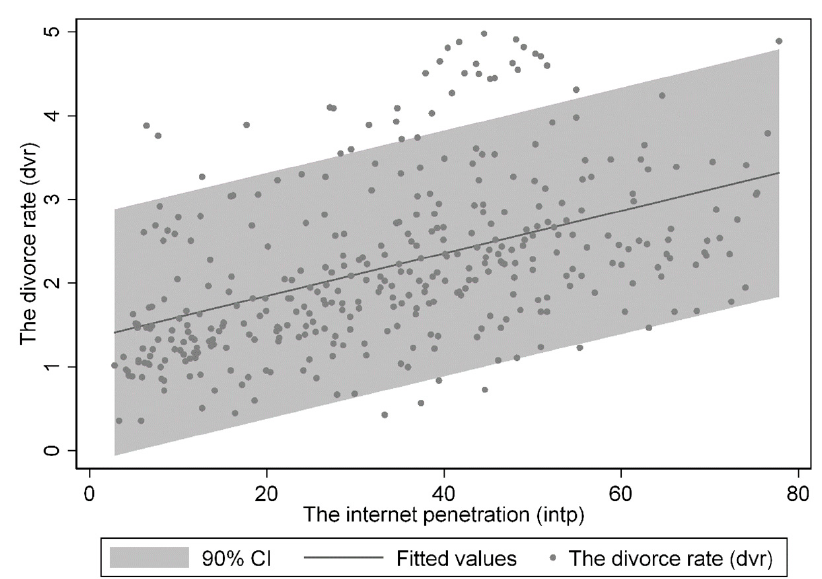
Figure 2. Scatter plot of CDRs and IPR.